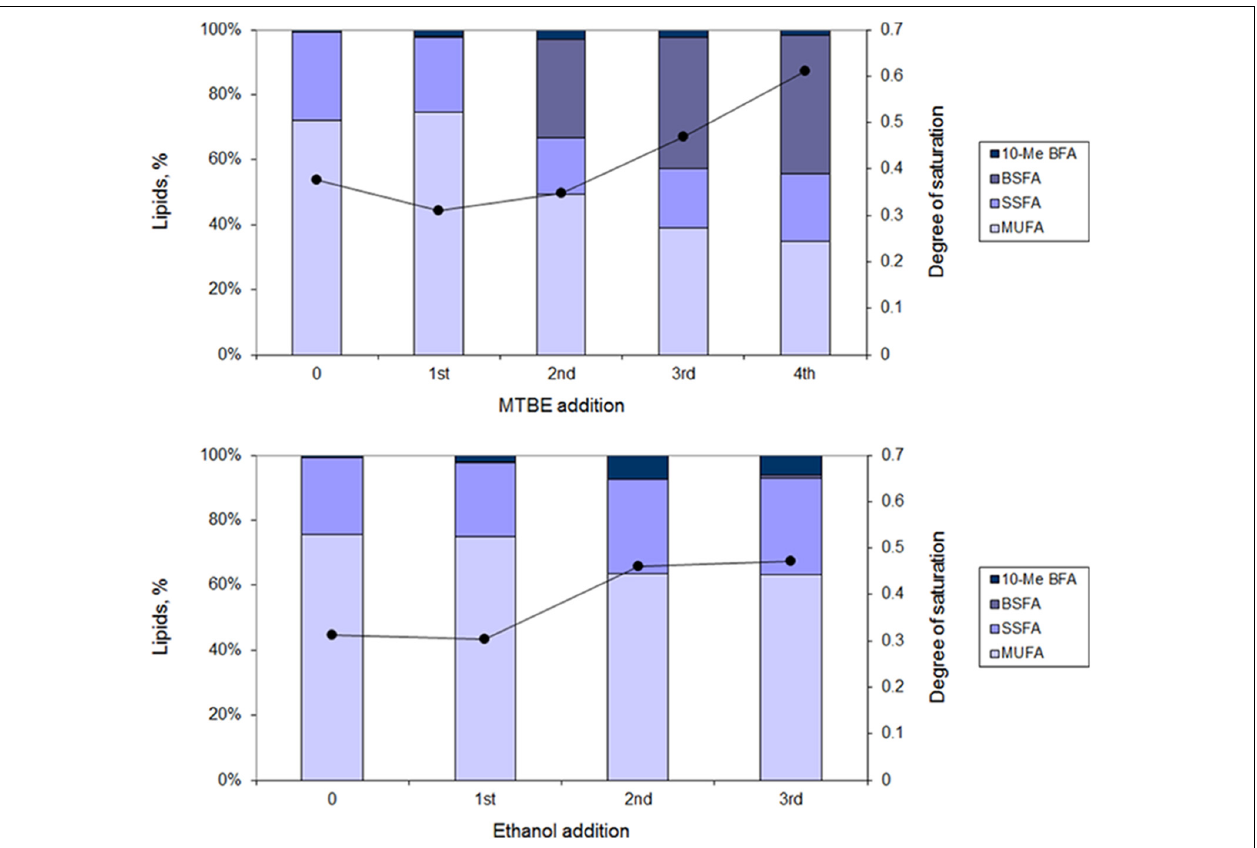
FIGURE 5 | Lipid composition (bars) and degree of saturation (line) of fatty acids of M. vaccae cells during adaptation to MTBE (Upper) and ethanol (Lower) . The lipid composition was measured 1 h following addition of the organic solvent. MUFAs, monounsaturated fatty acids; SSFAs, saturated straight fatty acids; BSFAs, branched saturated fatty acids; 10-Me BFA, 10-methyl branched fatty acids.